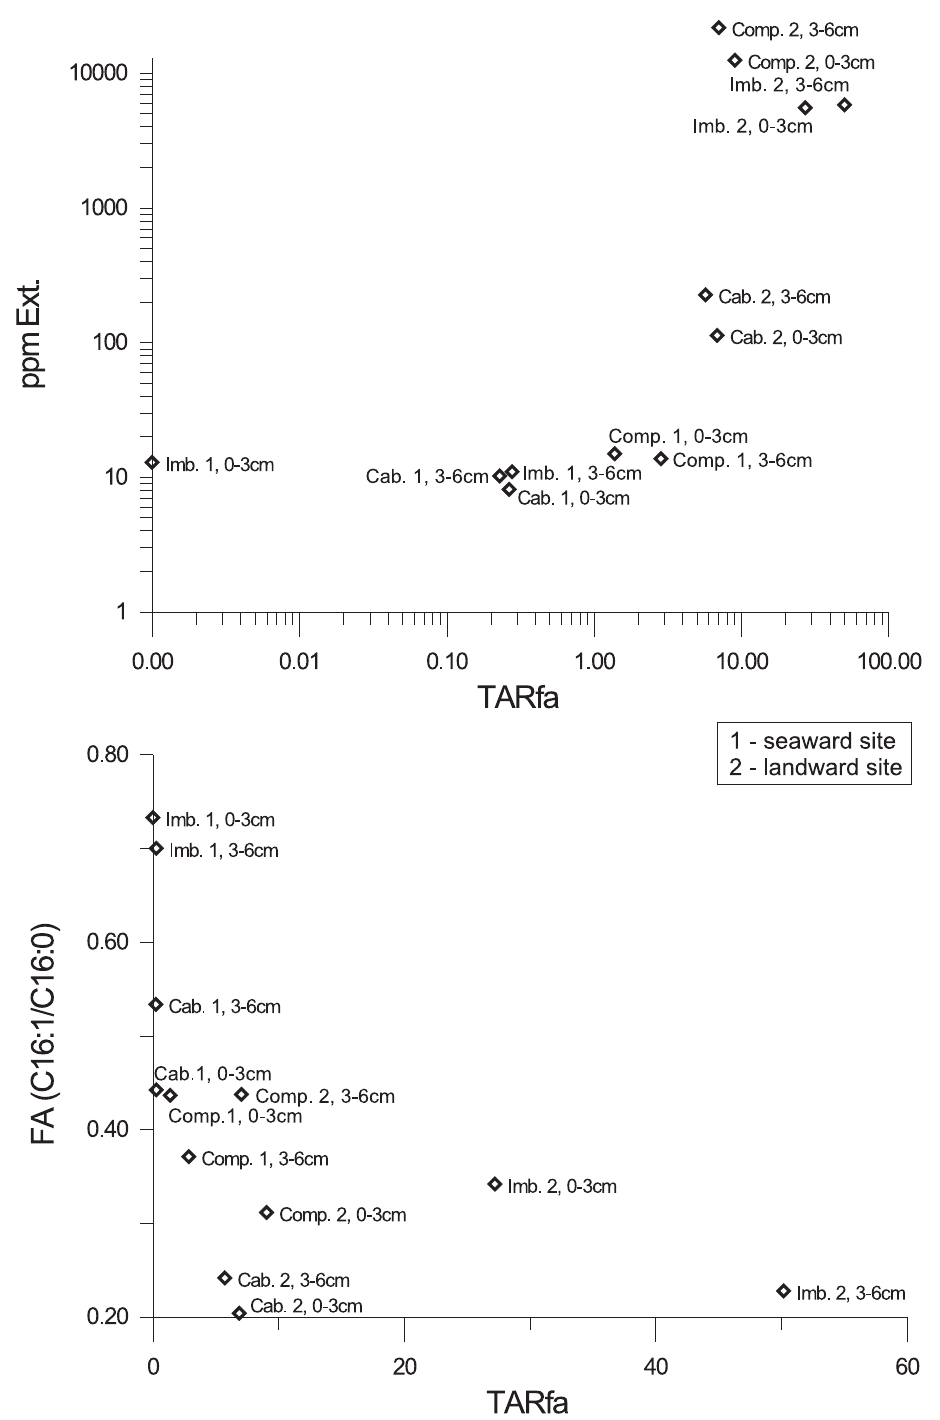
Fig. 4 – a) Crossplot of terrestrial over aquatic ratio of fatty acids [TARFA] versus extractable organic matter (ppm); b) Crossplot of terrestrial over aquatic ratio of fatty acids [TARFA] versus ratio of mono-unsaturated/saturated C16-fatty acids [FA(C16:1 ω 7/C16:0)].